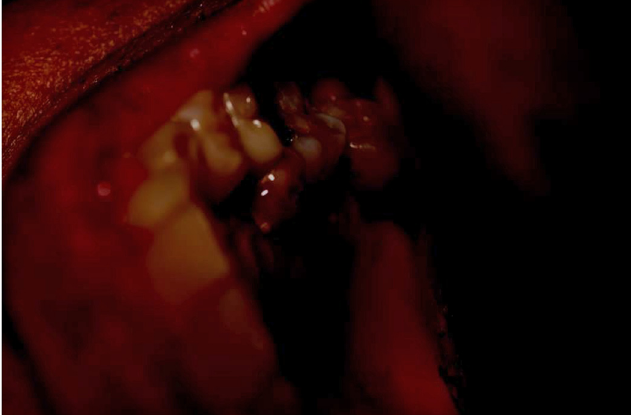
Fig. 3. New palatal lesion around 25 and 26 twenty days after the fi rst lesion was discovered.